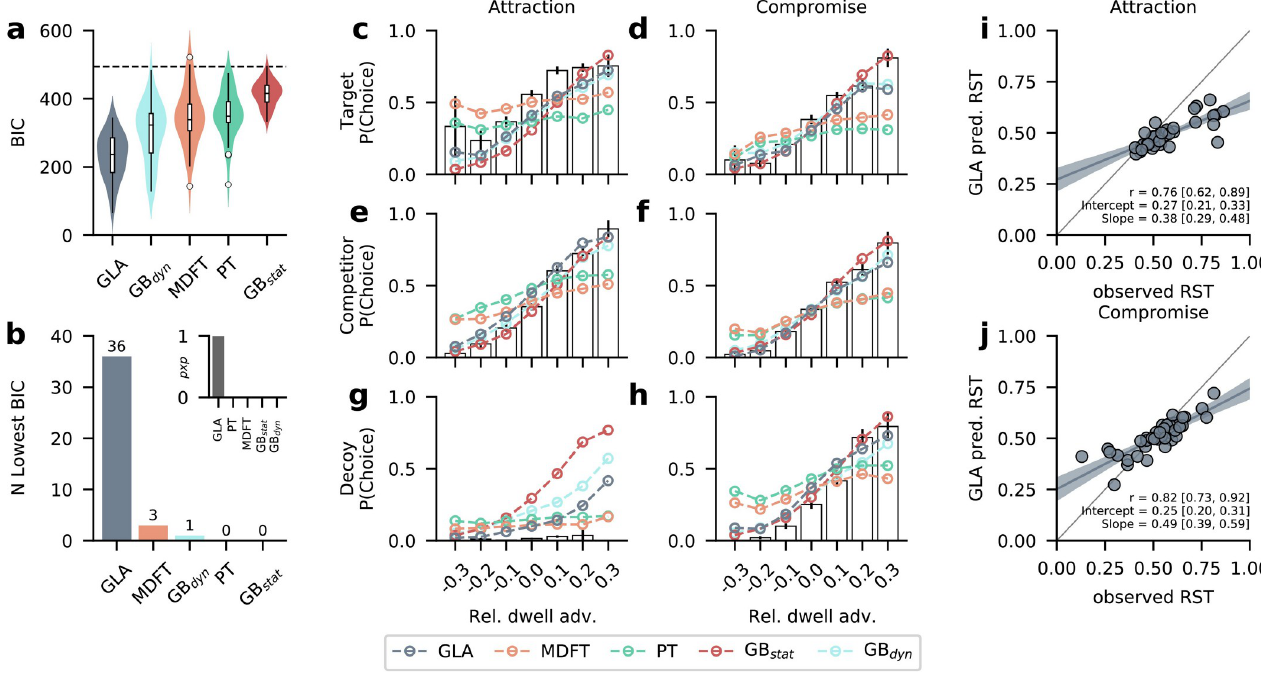
Fig 3. Model comparison and predictions. (a) The gaze-dependent leaky accumulator (GLA) provided the best fit (lowest mean BIC) across participants, followed by the dynamic gaze baseline model, MDFT, PT, and the static gaze baseline model. The dashed line indicates the BIC of the random choice baseline model. Violin plots show kernel density estimates of distributions of individual values. Box plots mark lower and upper quartiles and median. Whiskers extend from first and last datum within 1.5 times the interquartile range from lower and upper quartiles, respectively. Values outside this range are indicated by open circles. (b) The GLA fitted most (36 of 40, 90%) participants best, with a protected exceedance probability of 1 (inset). (c-h) Observed and model-predicted probability of choosing the target (c, d) , competitor (e, f) , or decoy (g, h) alternatives in attraction (c, e, g) and compromise trials (d, f, h) as a function of relative dwell time advantage. Relative dwell time advantage was computed as relative dwell time towards an alternative minus the mean relative dwell time to all other alternatives. White bars and error bars show mean ± s.e. observed data from even-numbered trials. Model predictions (coloured lines) are based on 50 simulations of each odd-numbered trial. (i, j) Observed and predicted RST of the best-fitting GLA for attraction (i) and compromise (j) trials. Each circle represents one participant. The winning model’s predicted context effect sizes correlated significantly with the observed ones. Strong context effects, however, were underestimated, as indicated by the reduced slopes. GLA: Gaze-dependent Leaky Accumulator. MDFT: Multialternative Decision Field Theory. PT: Prospect Theory. GB stat : Static Gaze Baseline. GB dyn : Dynamic Gaze